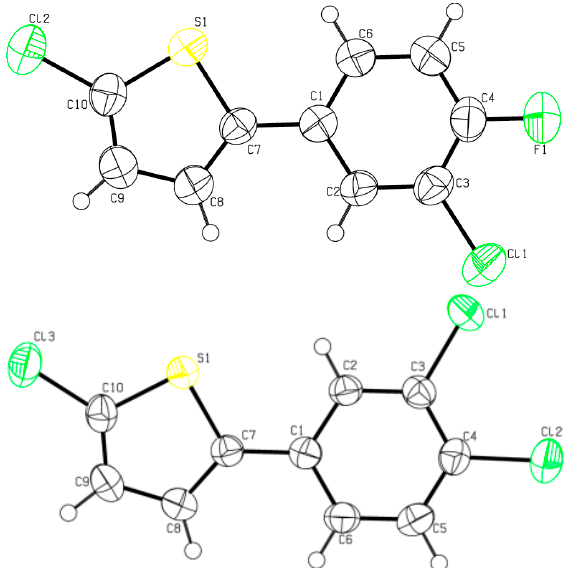
Figure 3. ORTEP plots of 2d and 2f .